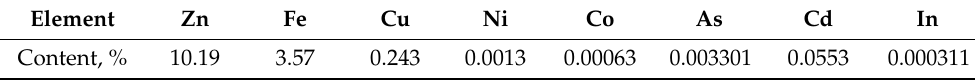
Table 1. Chemical composition of the pregnant leaching solution.